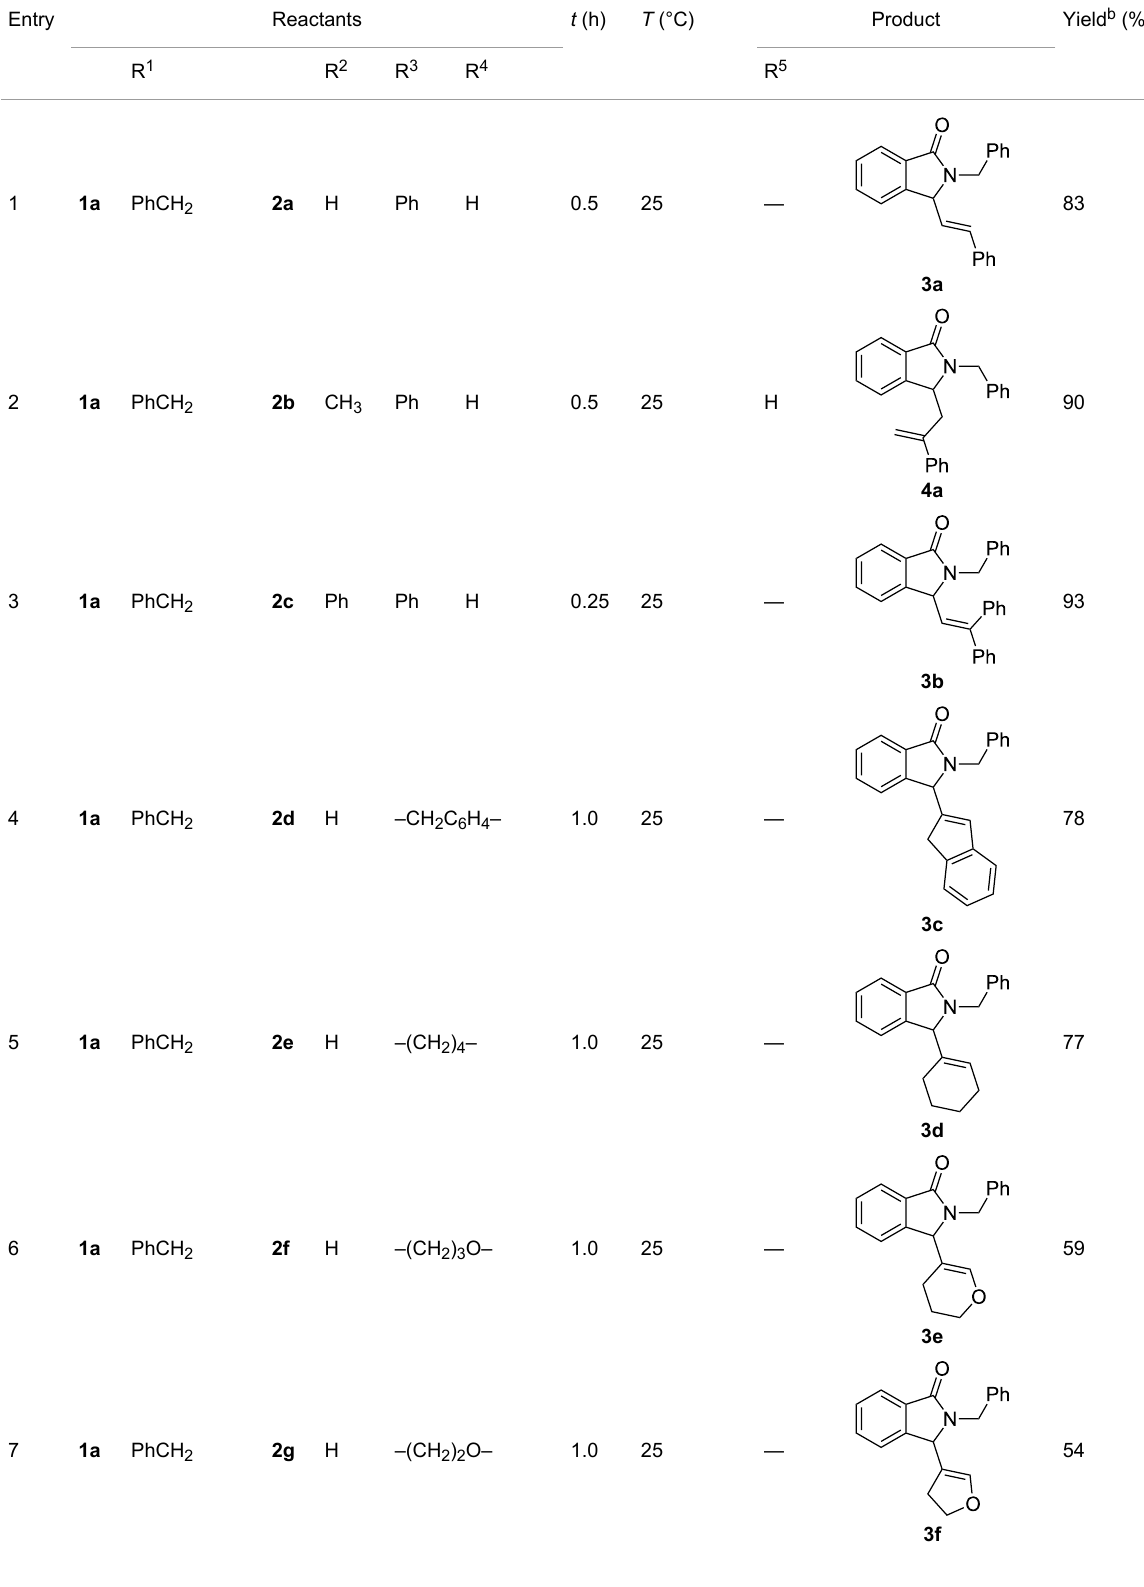
Table 2: The reactions of 3-hydroxyisoindol-1-one 1a with olefins 2 in the presence of BF 3 ·OEt 2 . a